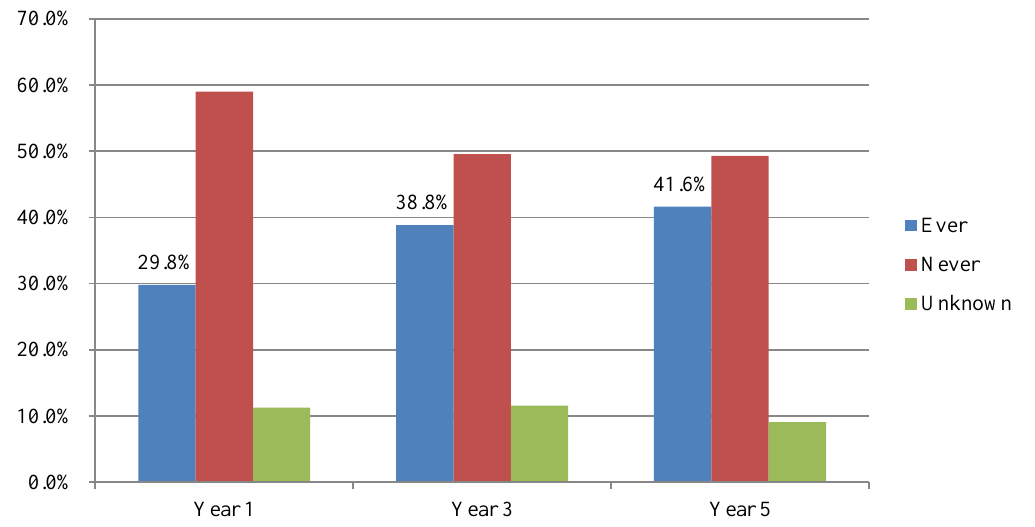
Prevalence of Paternal Incarceration in the Fragile Families Study over Waves (in percentages)